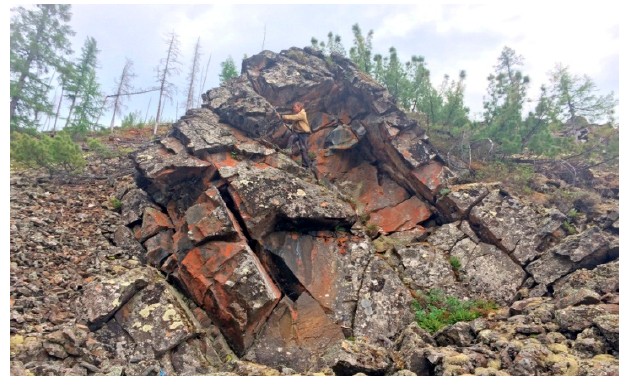
Figure 2. Dolerite sill near the Sakhara river (sample AC17-22).